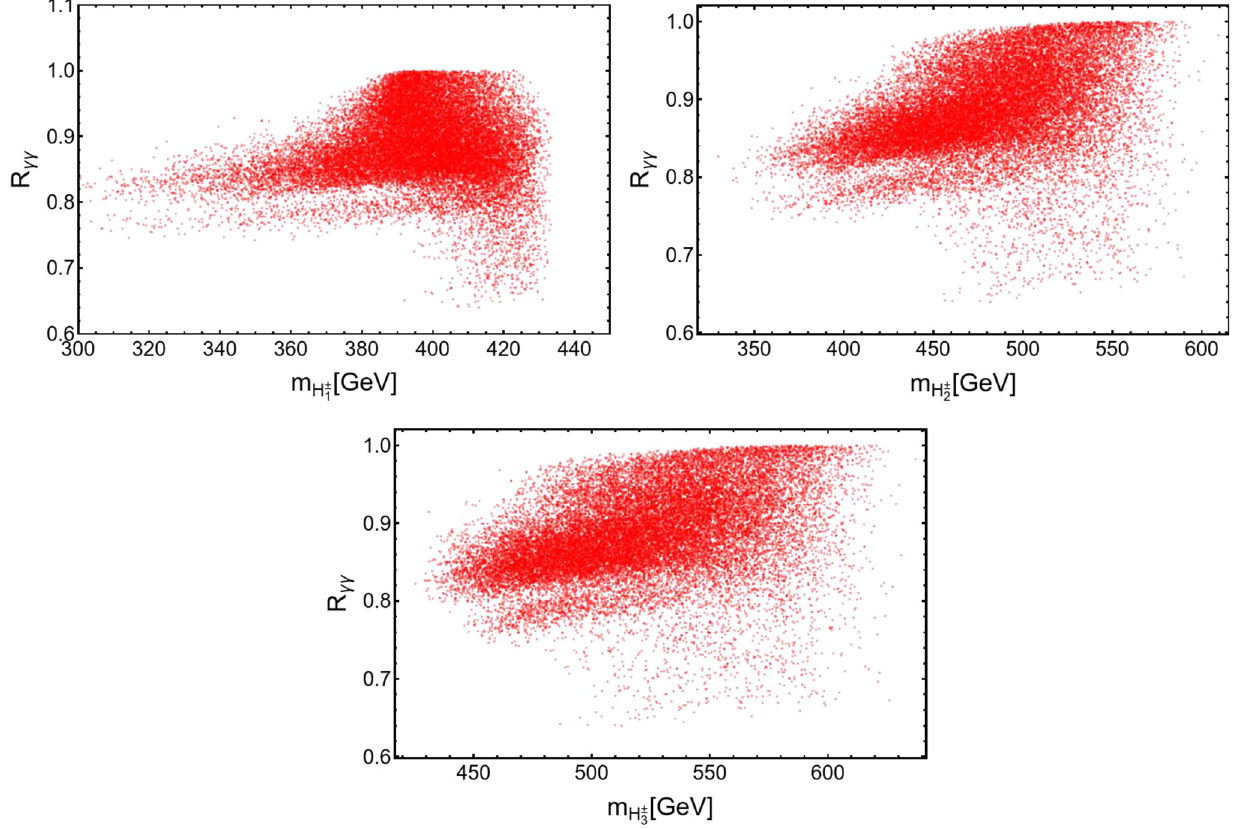
Fig. 6 Correlation of the Higgs diphoton signal strength with the charged scalar